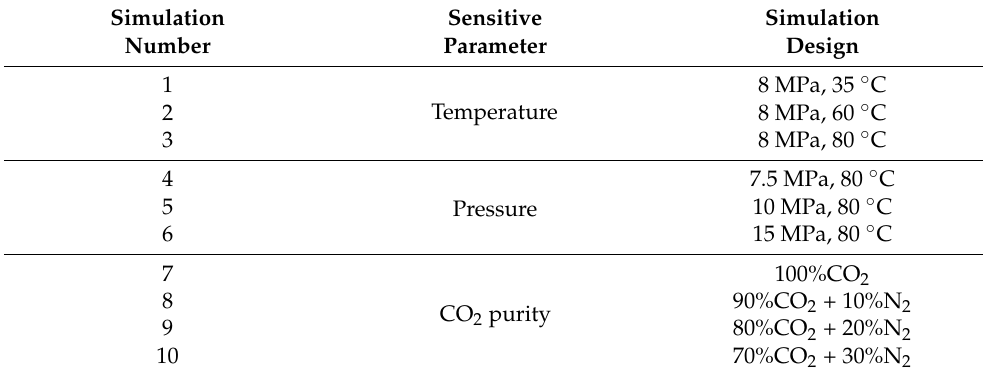
Table 7. Long core simulation design.